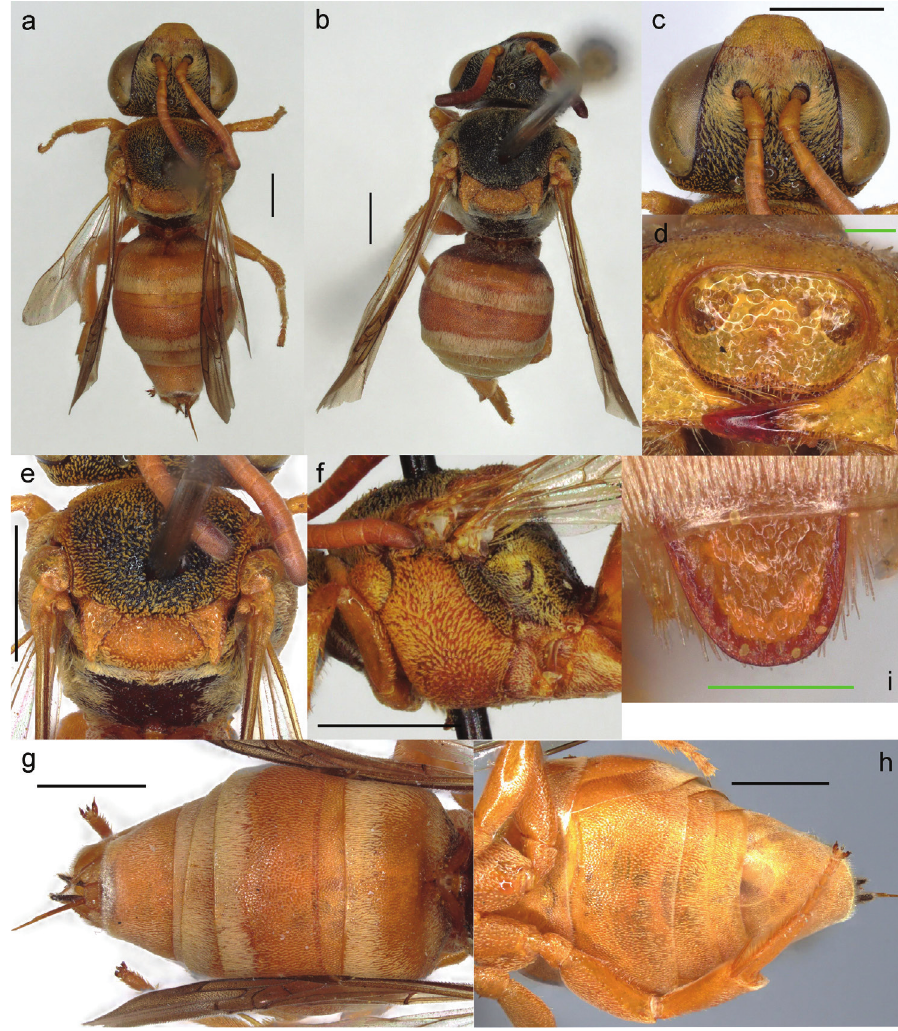
Figure 2. Epeolus priesneri sp. nov. a, c–h holotype, female b, i paratype, male a, b habitus, dorsal view c head, frontal view d labrum, frontal view e mesosoma, dorsal view f mesopleuron, lateral view g meta- soma, dorsal view h ventral view i pygidium, dorsal view. Scale bars: 1.0 mm ( a–c, e–h ); 0.1 mm ( d, i